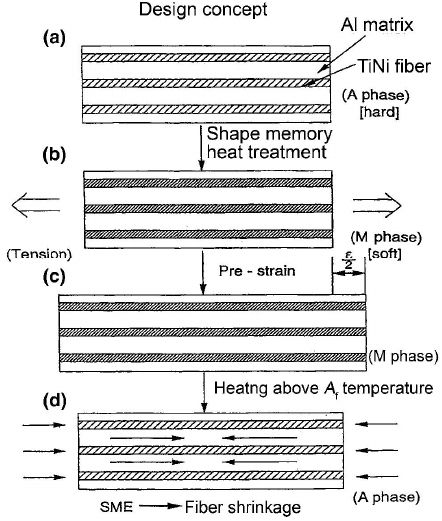
Figure 2. Design concept of shape memory alloy fiber-reinforced aluminum matrix Composite [28]. ( a ) As-fabricated composite; ( b ) Cooled composite; ( c ) Pulled composite; ( d ) Reheated composite.